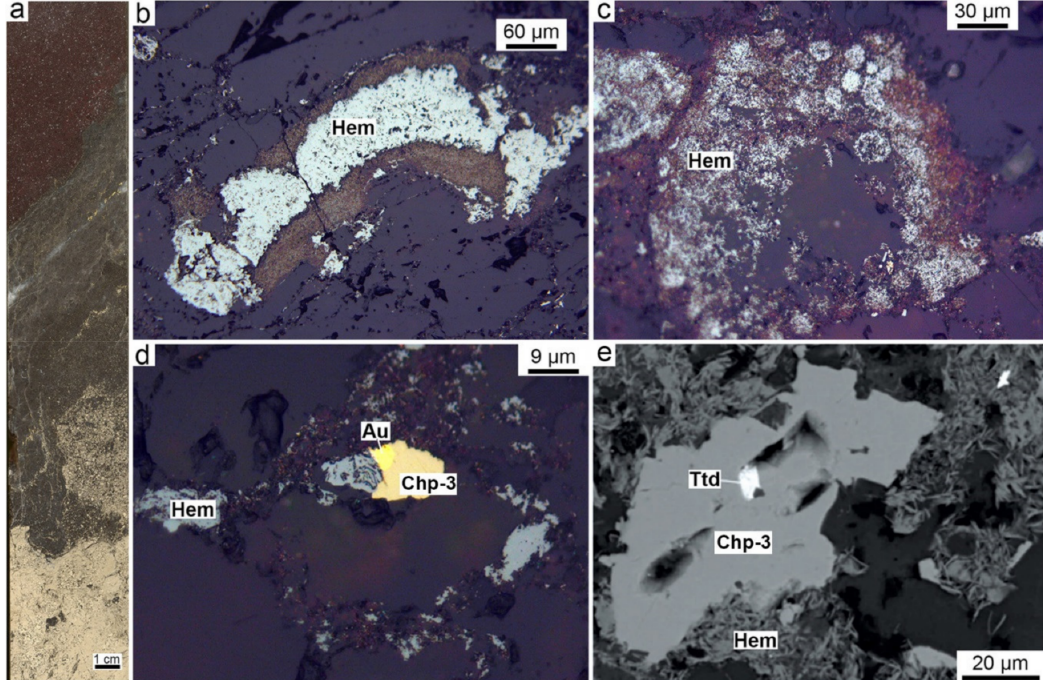
Figure 19. Mineralogical features of Fe-rich gossanites of the Aleksandrinskoe deposit: ( a ) Hematite gossanite on top of barite and clastic pyrite layers; ( b , c ) pseudomorphic hematite after colloform pyrite clast ( b ) and framboidal pyrite nodule ( c ); ( d ) native gold at the contact of chalcopyrite and hematite grains; ( e ) inclusion of tetradymite in chalcopyrite and hematite. ( a ) Polished sample, ( b , c , d ) reflected light, ( e ) SEM